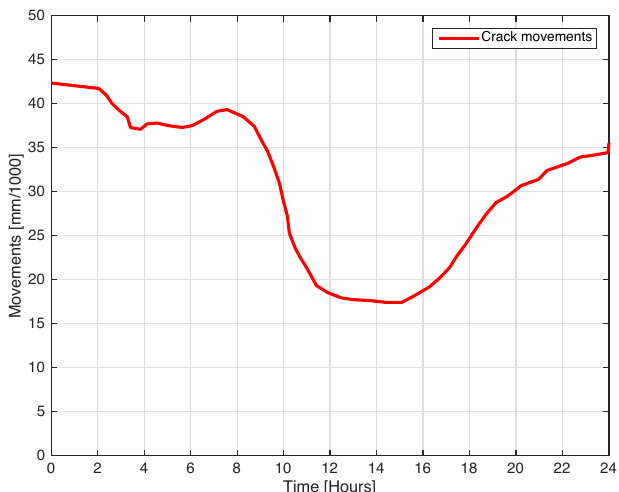
Figure 14. Crack movements vs. time. One day measurement showing the small movement due to temperature changes. Tag placed in position A.